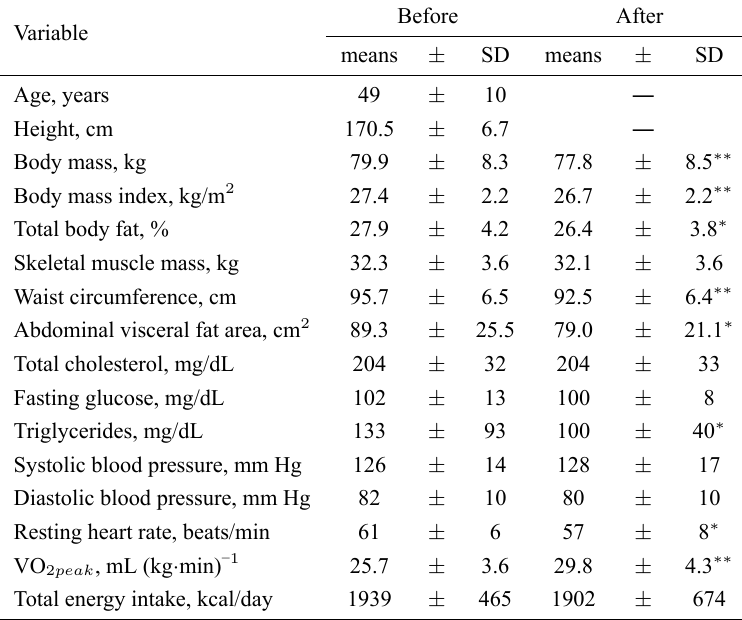
Table 1. Participants